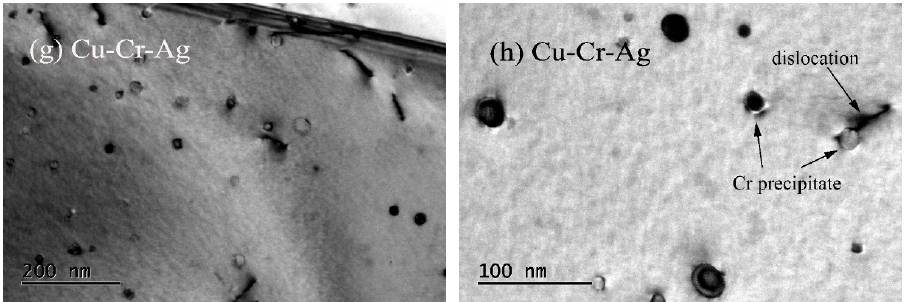
Figure 7. Microstructures of alloys after creep test at 500 °C. Bright-field images of ( a – d ) Cu–Cr and ( e – h ) Cu–Cr–Ag alloys.